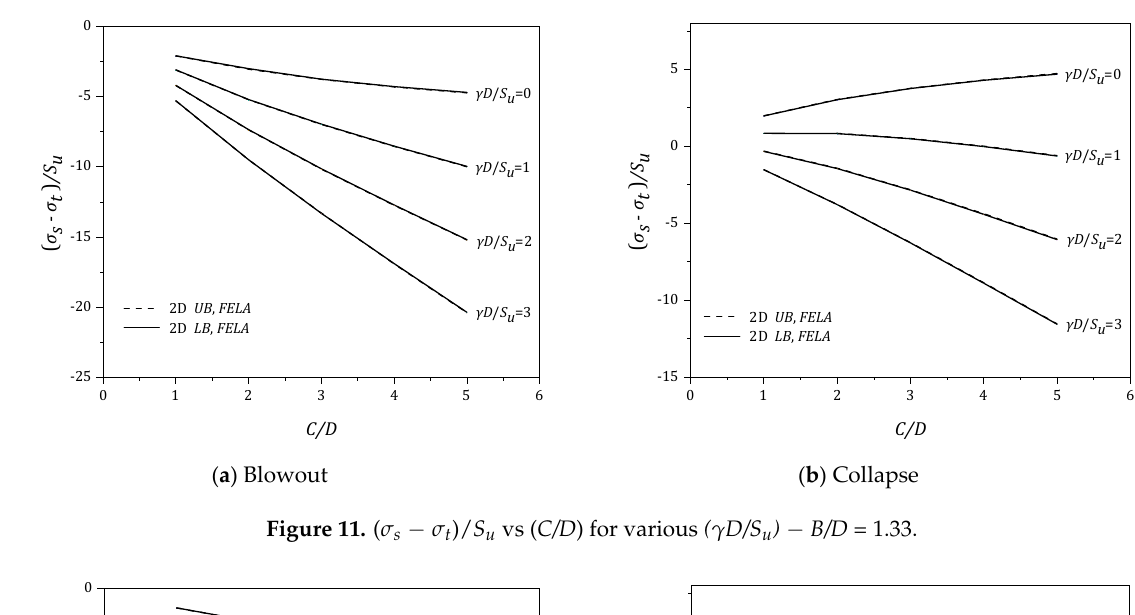
Figure 10. ( σ s − σ t )/ S u vs ( C/D ) for various ( γ D/S u ) − B/D = 1.